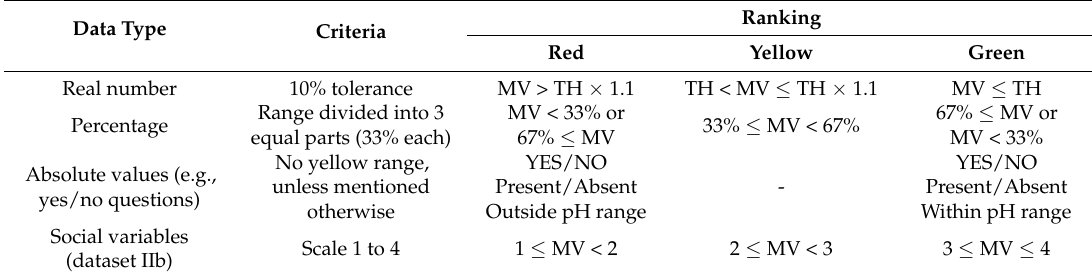
Table 3. Colour ranking in Sustainability